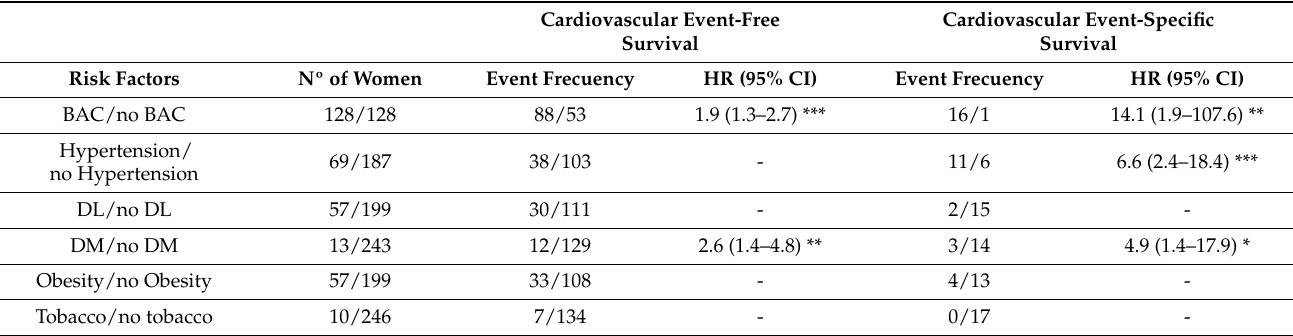
Table 3. Multivariate analysis of the relationship of classical risk factors at the beginning of the study and BAC with cardiovascular event-free and cardiovascular event-specific